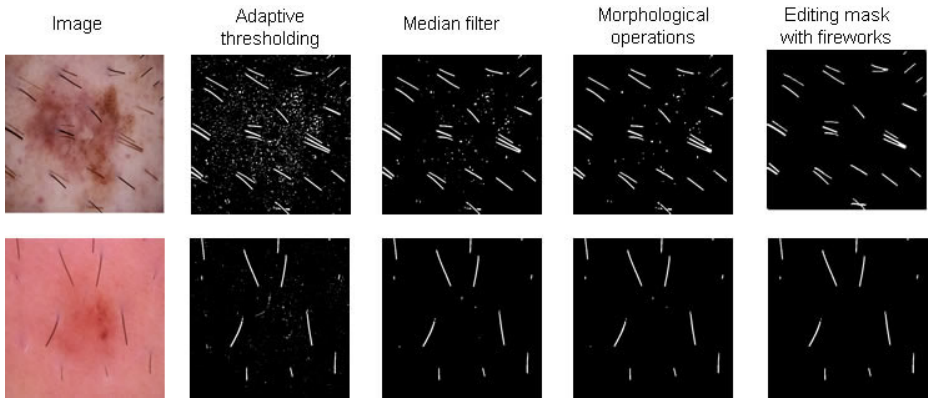
Figure 2. The cleanup dataset creation process.